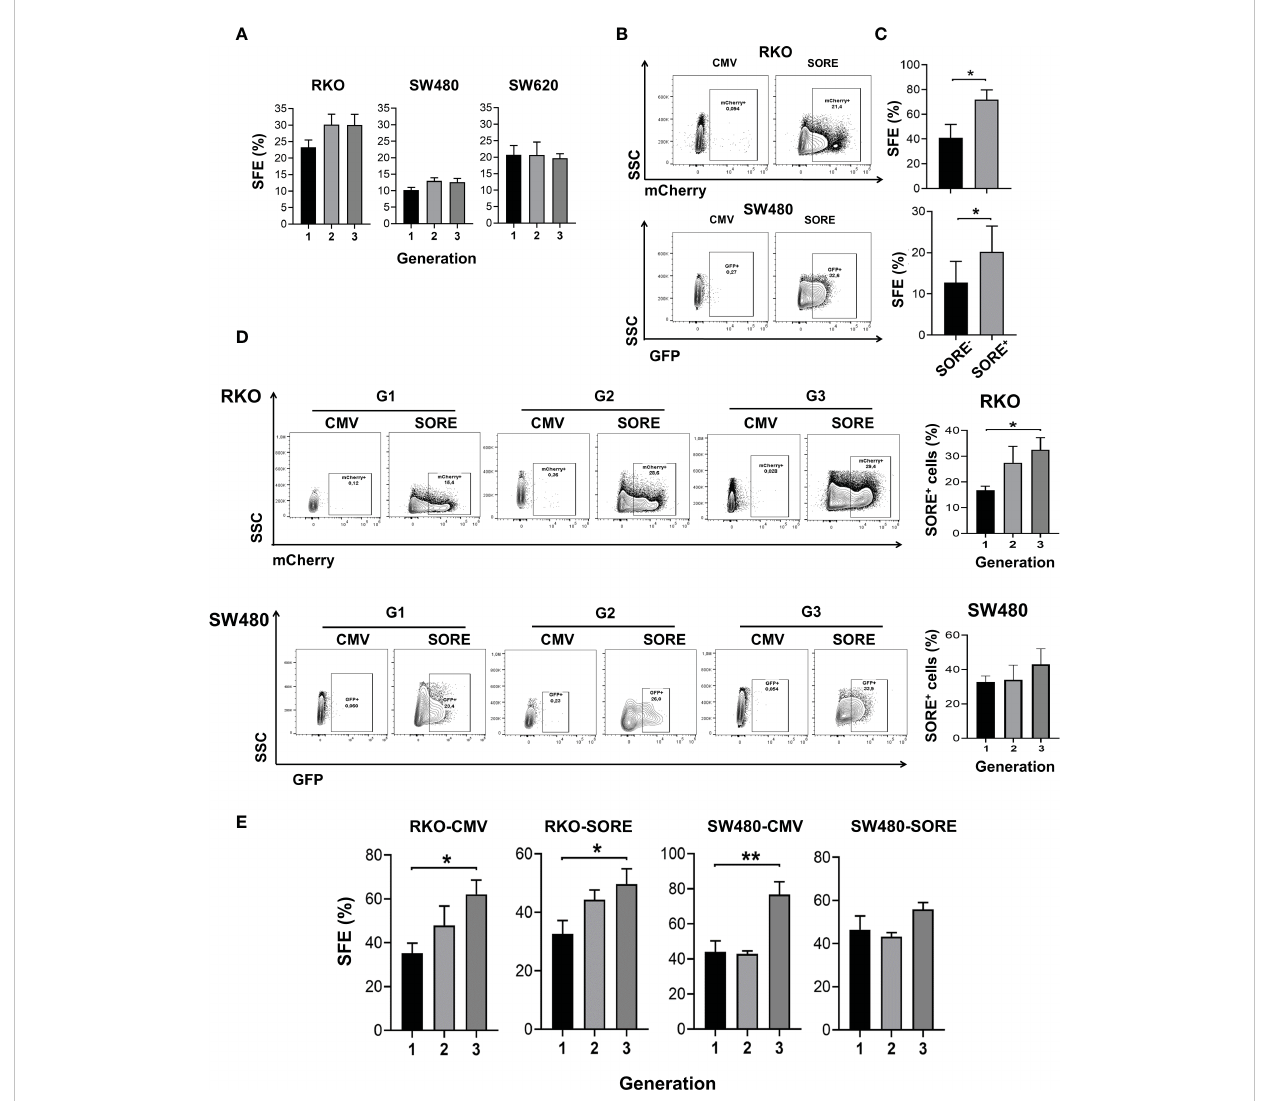
FIGURE 1 CSC are identi fi ed in spheres cultures derived from colon cancer cell lines. (A) Quanti fi cation of SFE of RKO, SW480, and SW620 cells throughout three consecutive generations. (B) Density plots of RKO and SW480 cells transduced with pSORE6/mCherry or pSORE6/GFP, respectively, and measured by fl ow cytometry. Transduced cells with pCMV were used as a reference for fl uorescence. (C) Quanti fi cation of SFE of single cell cultures sorted from SORE6 - and SORE6 + subpopulations of RKO SORE6 and SW480 SORE6 populations. (D) Density plots of RKO SORE6 and SW480 SORE6 throughout three consecutive generations (left panel). Quanti fi cation of the percentage of SORE6 + subpopulation of each generation (right panel). (E) Quanti fi cation of SFE of RKO CMV , RKO SORE6 , SW480 CMV , and SW480 SORE6 throughout three consecutive generations. Data are represented as the mean values ± SEM of at least three independent experiments using Student´s t-test. (A, D, E) or one-way ANOVA followed by Bonferroni´s multiple comparisons. *p<0.05;